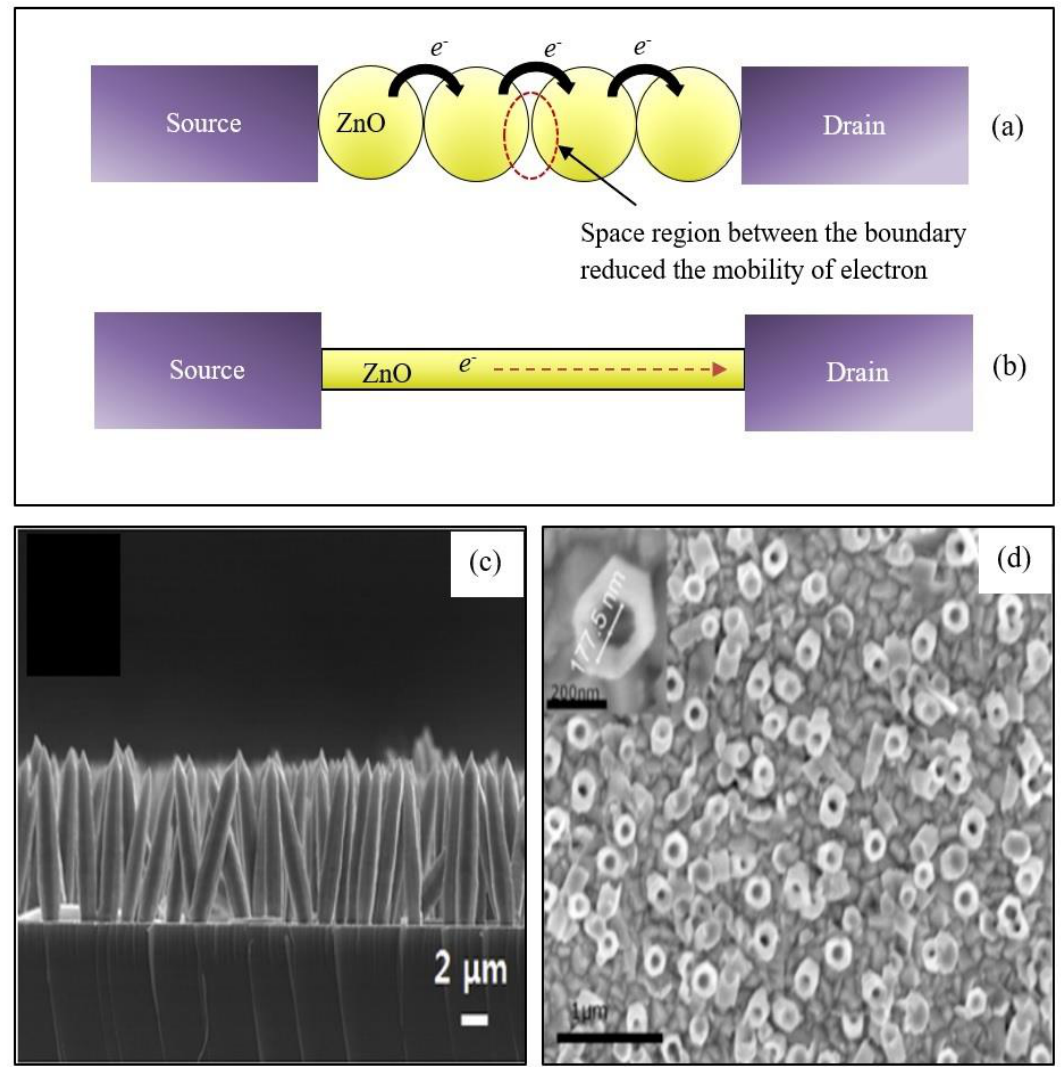
Figure 7. Schematic diagram for electron flow through ZnO nanostructure bridges between source and drain for ( a ) nanoparticles and ( b ) single lateral nanowire. ( c ) Cross-sectional image of ZnO nanorods. Reprinted from [94]. Copyright 2014, with permission from Elsevier. ( d ) Top view FESEM image of ZnO nanotubes. Reprinted from [19]. Copyright 2018, with permission from Elsevier.